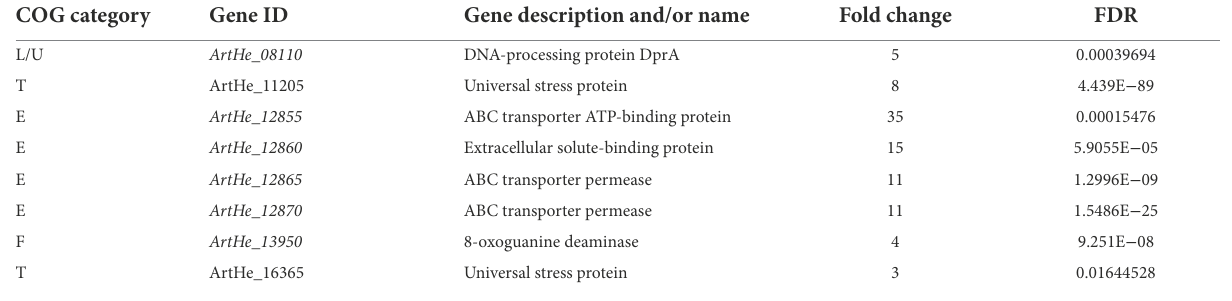
TABLE 3 DEGs involved in DNA repair and protection and general stress in PEG35 vs. PEG0.